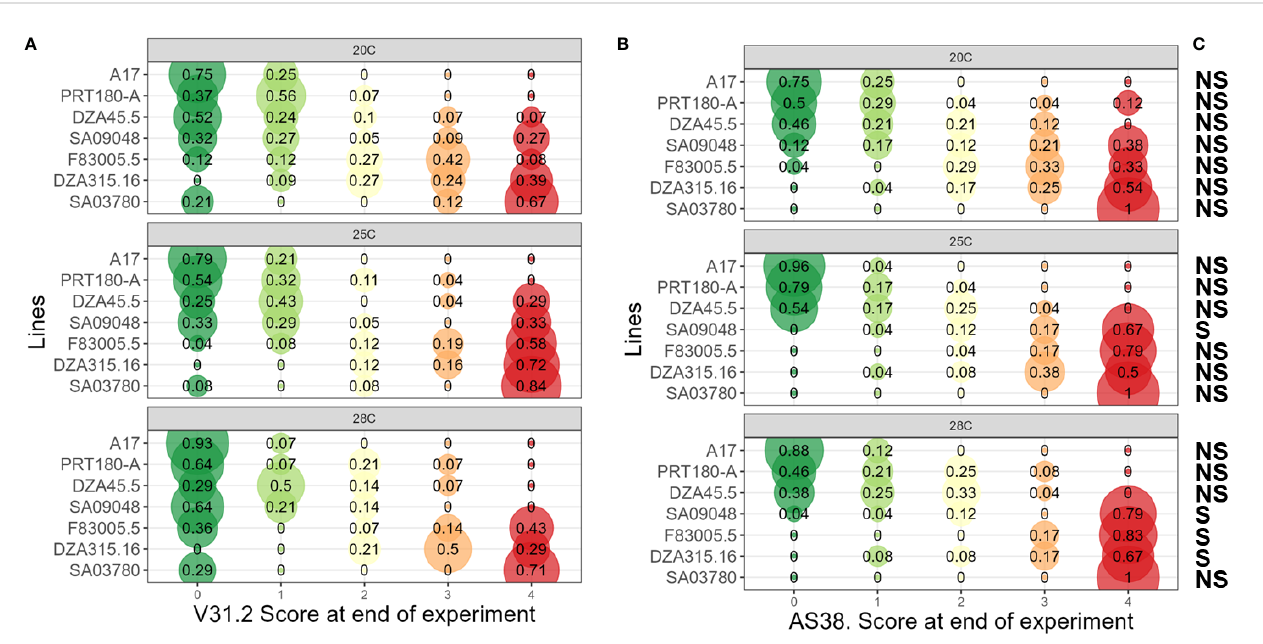
FIGURE 4 Assessment of Maximum Symptom Score of M. truncatula to V. alfalfae V31-2 and the AS38 derived mutant at different temperatures. Seven M. truncatula lines (A17, PRT180-A, DZA45.5, SA09048, F83005.5, DZA315.16 and SA03780) were root-inoculated with a spore suspension of Verticillium strains V31-2 (A) and AS38 (B) and maintained at 20°C, 25°C and 28°C. Symptoms were scored regularly on a scale from 0 to 4 during four weeks. At the end of the experiment, maximum symptom scores were determined for each plant. The values are from three independent experiments with at least eight plants per combination. Each bubble ’ s diameter is proportional to the percentage of plants belonging to a symptoms class, with this proportion indicated at the center. Colour code from green (score “ 0 ” , no symptoms) to red (score “ 4 ” , dead plant). Score classes at the end of the experiments were analyzed using proportional-odds models, used for modeling the dependence of an ordinal response (disease symptom scores) on discrete (pathogen strains and plant lines) or continuous (temperature) covariates. Multiple comparisons of odd-ratio were done using least square means and Tukey HSD. (C) NS/S indicates if a signi fi cant difference exists between the response of a M. truncatula accession to AS38 compared to its response to V31-2, for a given